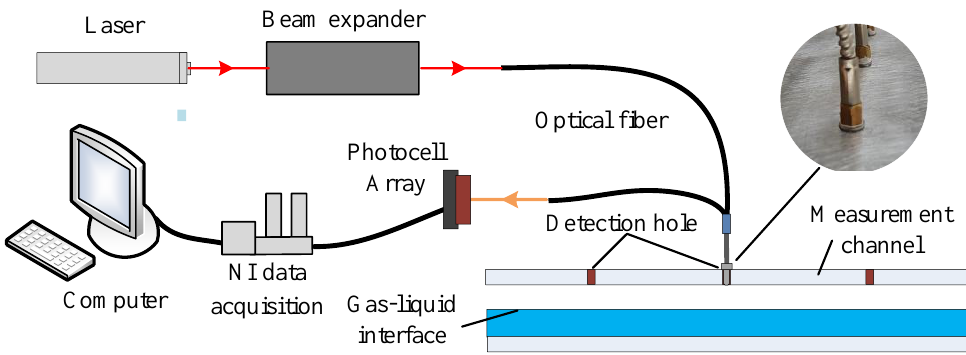
Figure 1. The setup of the distributed optical measurement system.